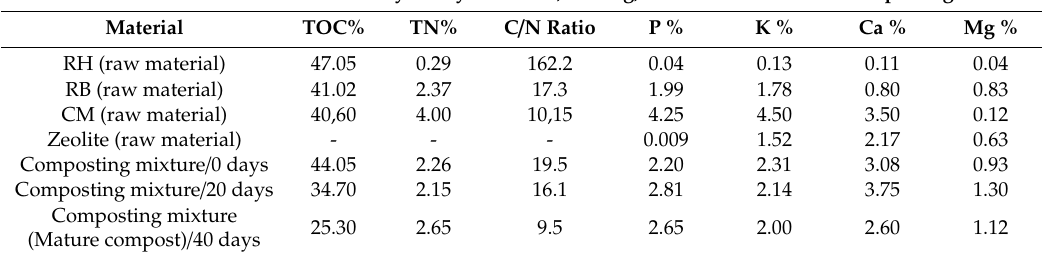
Table 2. Laboratory analysis of the main raw materials (RH, RB, CM, and zeolite), the initial composting mixture at 0 days, and the composting mixture at 20 and 40 days (mature compost), utilized in 2017 and 2018 experimentation.